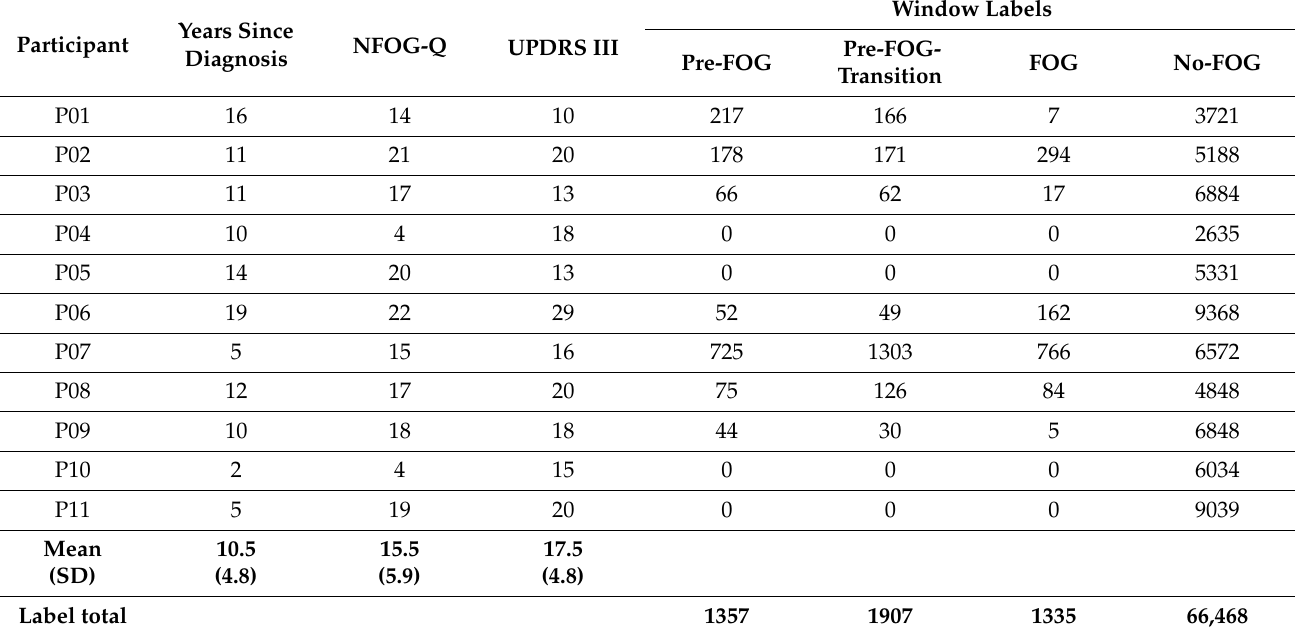
Table 3. Clinical details of the participants: number of years since PD diagnosis, New Freezing of Gait questionnaire (NFOG-Q), Unified Parkinson’s Disease Rating Scale Section III (UPDRS III); and number of data windows of each label extracted from each participant.